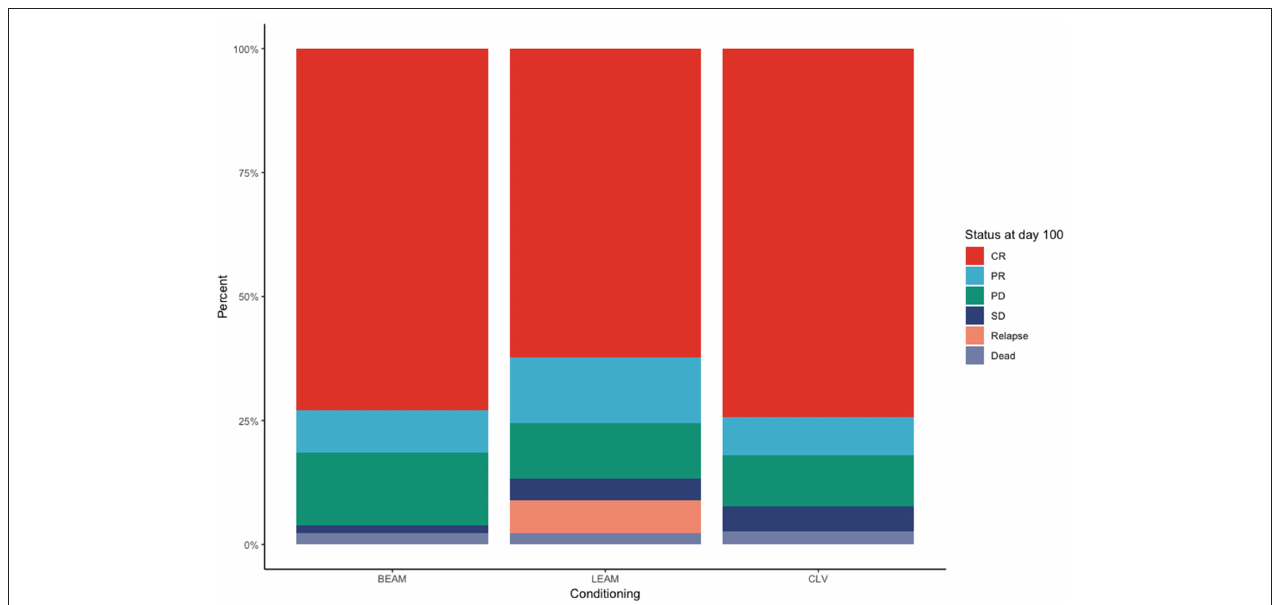
FIGURE 1 | Status of the patients treated with the three conditioning chemotherapy regimens at day + 100.